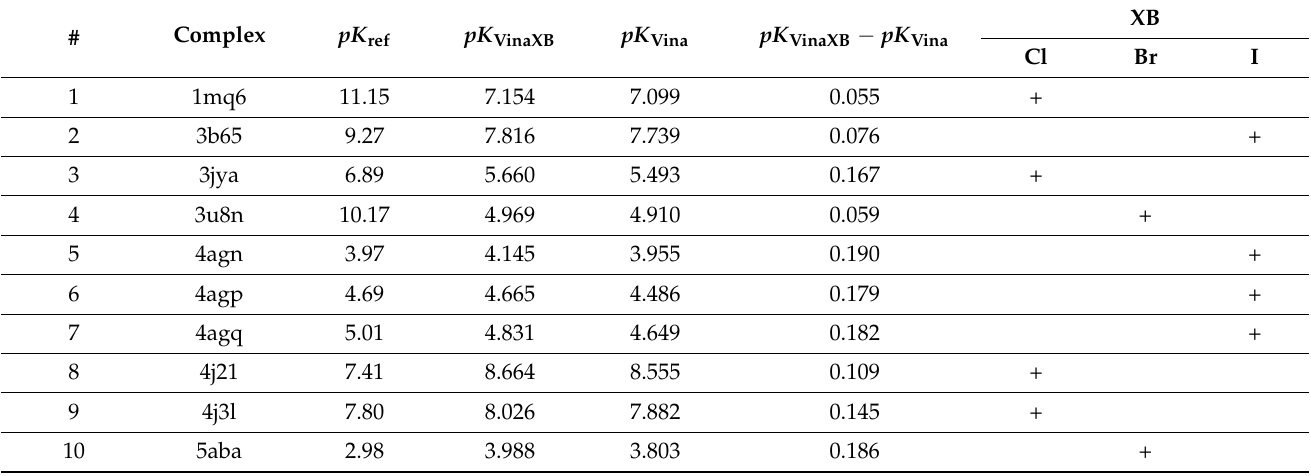
Table 7. Difference between AutoDock Vina and AutoDock VinaXB estimated pK values for complexes with non-zero contribution of the halogen bonding (according to AutoDock